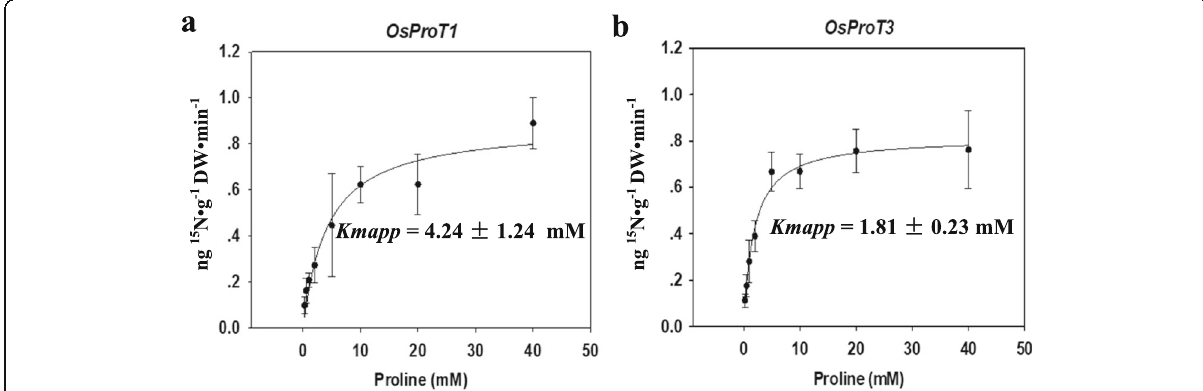
Fig. 5 OsProT1 and OsProT3 are low affinity Pro transporters. a and b, OsProT1 (a) or OsProT3 (b) expressed yeast strain 22 △ 10 α was cultivated with different concentrations of 15 N-labeled Pro for 10 min and the 15 N content was subsequently determined after being collected and dried. Kmapp values were calculated by fitting to the Michaelis-Menten equation in the SigmaPlot 12.0 program. Data are means ± SD, n =